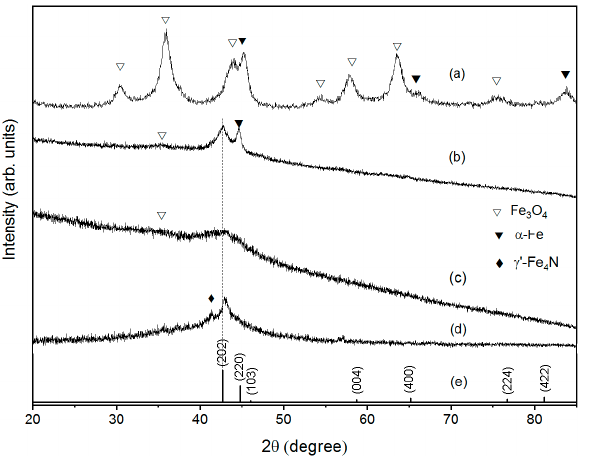
Figure 2. Powder XRD patterns of the products synthesized under different reaction conditions: ( a ) 393 K and three days, ( b ) 403 K and three days, ( c ) 433 K and six days, ( d ) 453 K and six days, ( e ) JCPDS XRD card of #78-1865 for α″ -Fe 16 N 2 .